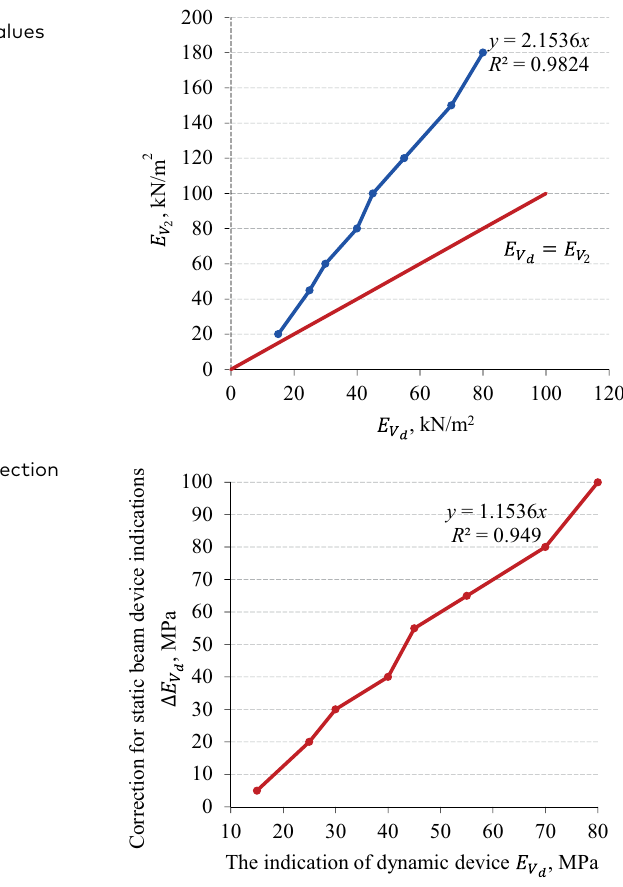
Figure 2. Dependencies of the E Vd transfer to the E